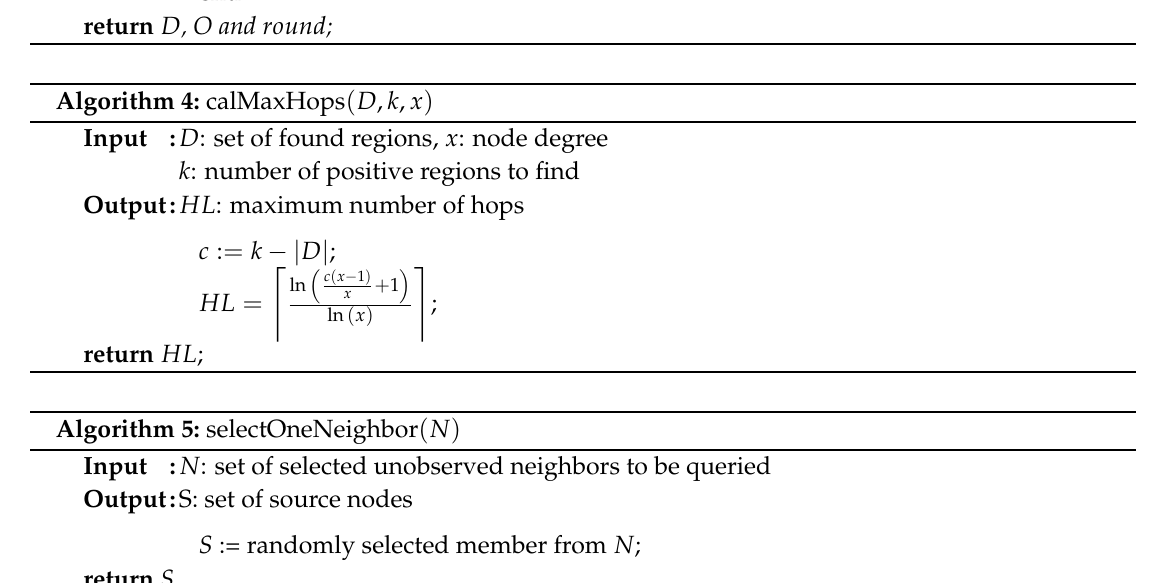
Algorithm 4: calMaxHops ( D , k , x )